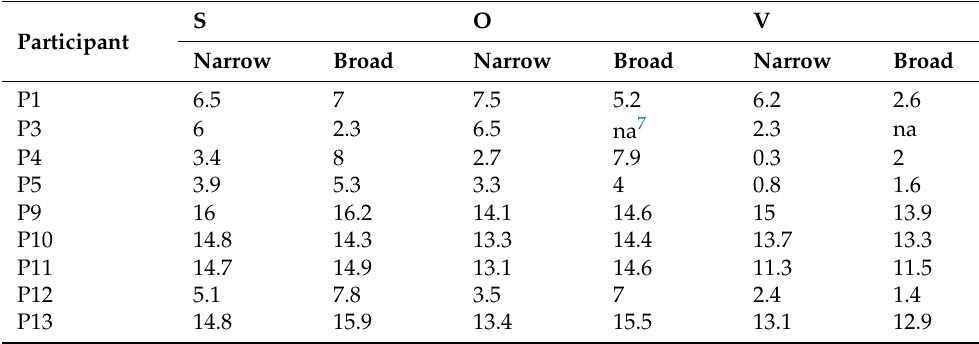
Table 2. Mean f0 values (in ST) obtained from utterances with narrow focus on the subject and with broad focus displayed by